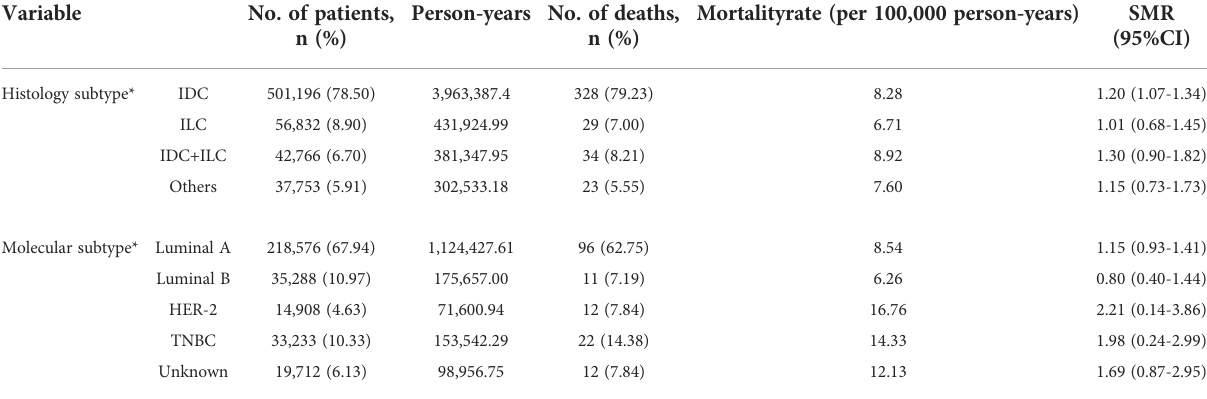
TABLE 2 Suicide rates, according to breast cancer sub-types, female breast cancer survivors. Variable